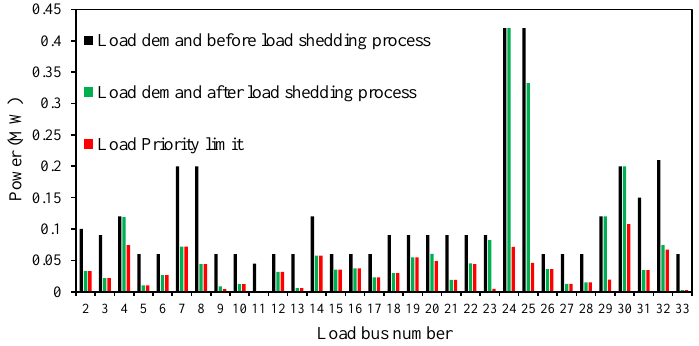
Figure 10. Loads demand at each bus after performing the proposed load-shedding technique at time 15:00 hour for island with their load priority limits.